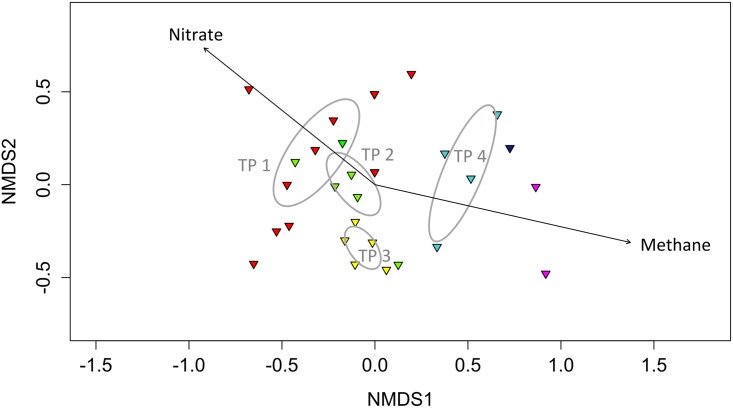
NMDS plot (stress 0.13) of 16S rRNA bacterial DGGE banding patterns.Arrows indicate the direction triggered by methane and nitrate as the strongest analyzed environmental factors. Ellipses indicate a confidence interval of 95% and ANOSIM analysis was significant (p = 0.001, r = 0.558). Colors indicate the six transitions phases (TP): red = TP 1 (Transition from oxygen to nitrate as electron acceptor), green = TP 2 (Short oxic pulse), yellow = TP 3 (nitrate depletion and sulfide development), light blue = TP 4 (Nitrate additions under sulfidic condition), dark blue = sulfidic phase, purple = oxic phase.